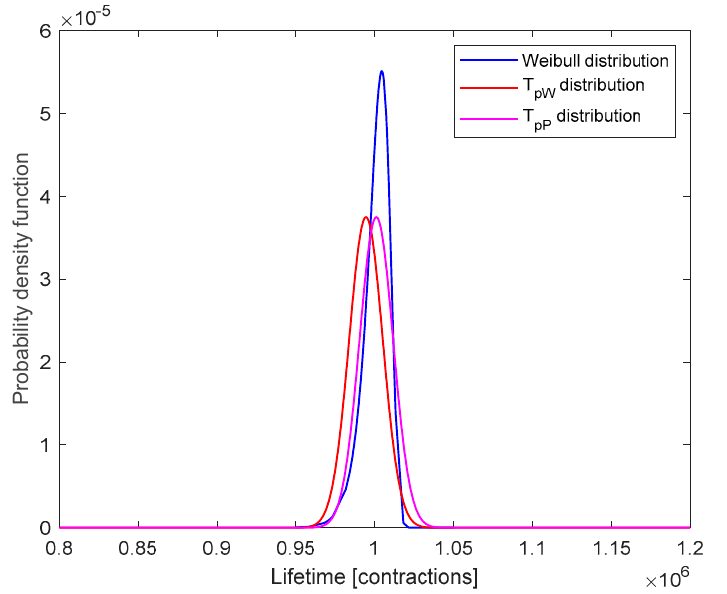
Figure 5. Probability density functions. Table 2. Results obtained in the maintenance cost optimization.